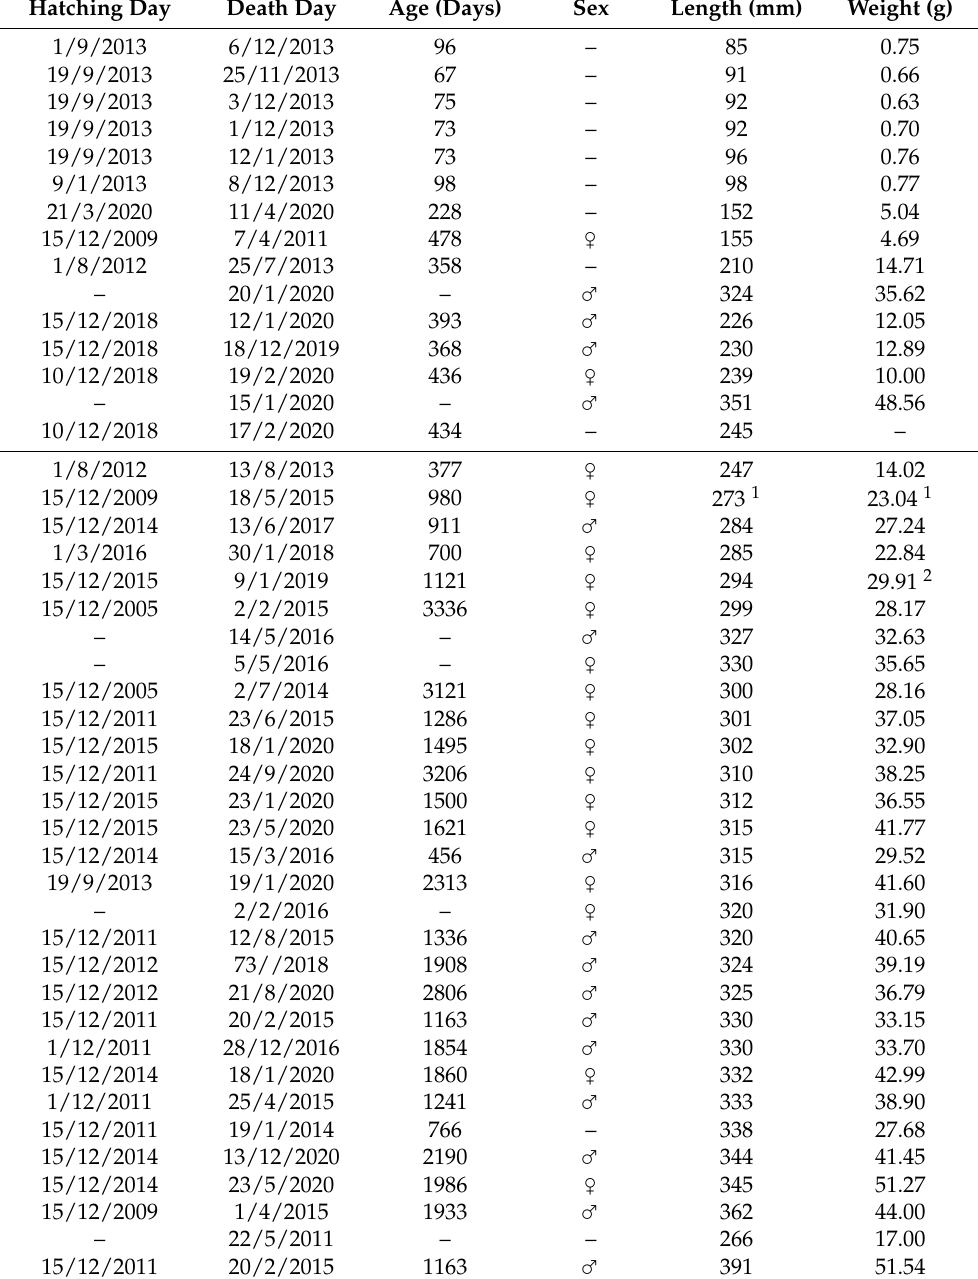
Table 1. Hatching and death dates (day/month/year), ages, ‘scalene’ lengths (see text) and weights of common seadragons ( Phyllopteryx taeniolatus ) kept at the Birch Aquarium at Scripps, La Jolla,